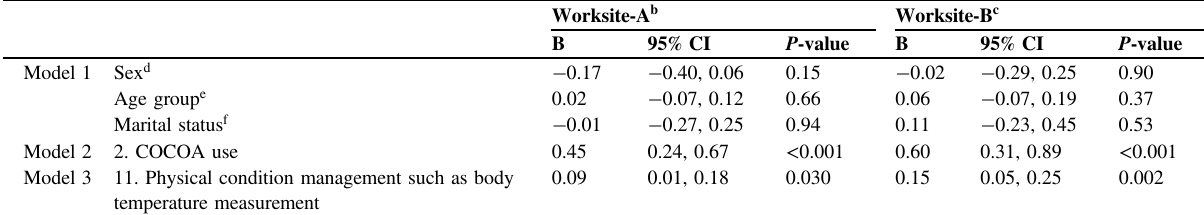
Table 2 Results of hierarchical linear regression analysis, Ibaraki ’ s Amabie-chan use a as dependent